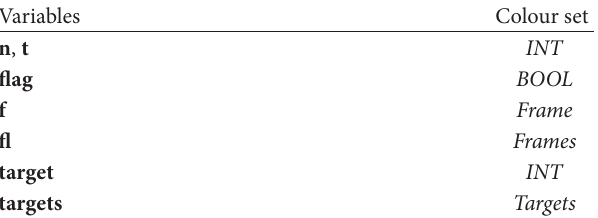
Table 2: Variables in